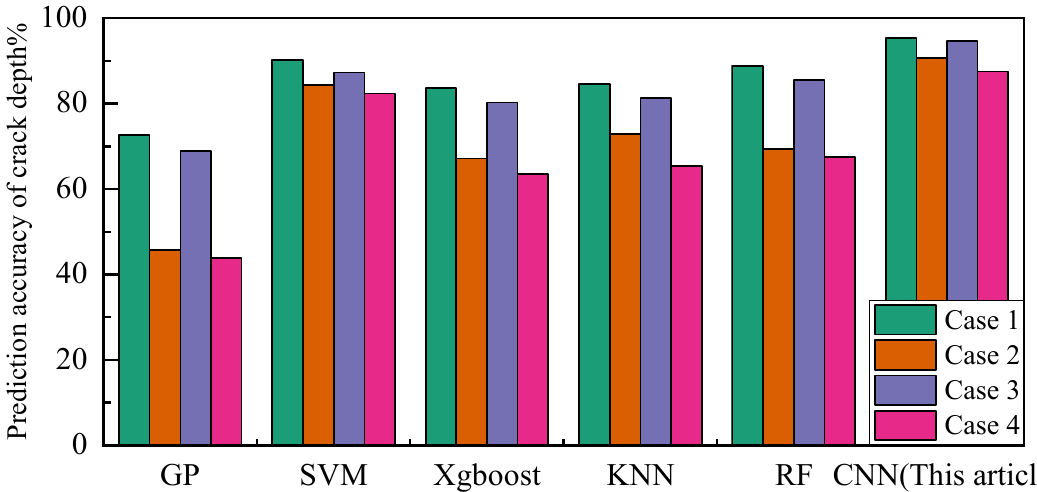
Figure 8. Prediction accuracy of blade crack depth by different deep learning models (case 1: No system deviation and No noise; case 2: System deviation and No noise; case 3: Noise and No system deviation; case 4: System deviation and Noise).